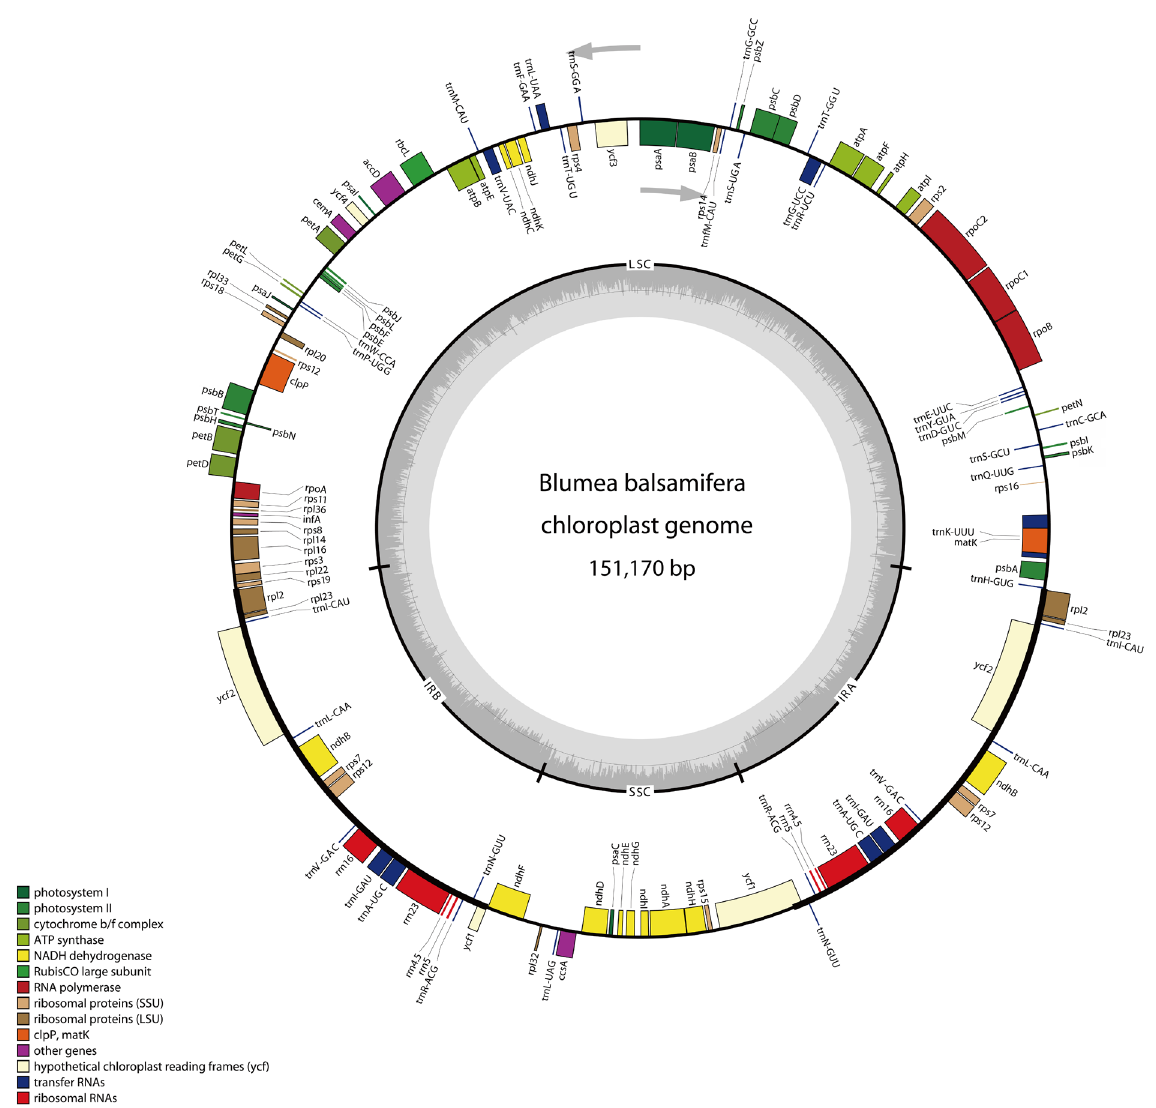
Figure 1 – Gene map of the complete cp genome of Blumea balsamifera . Genes present within the circle are transcribed clockwise and those outside are transcribed counterclockwise. Genes are color-filled based on different functions. Inverted repeat (IR), small single-copy (SSC), and large single-copy (LSC) regions are